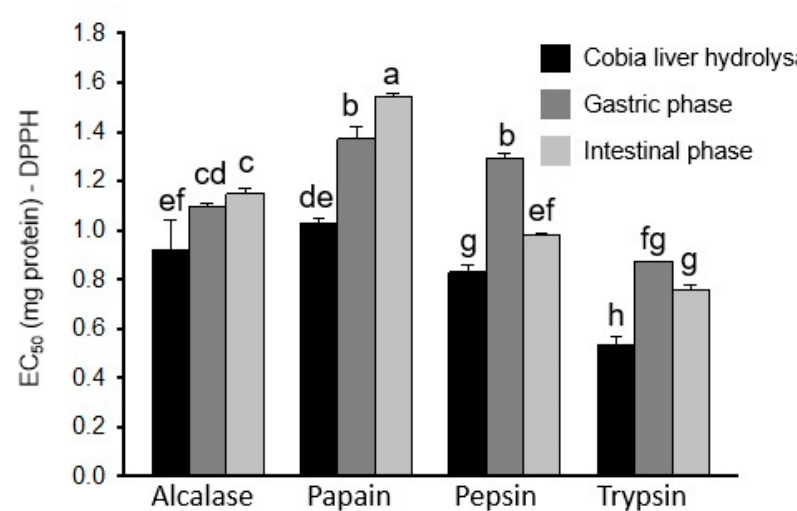
Figure 5. Effect of simulated gastro-intestinal digestion in vitro on EC 50 values (effective concentration scavenges 50% radical) for DPPH radical scavenging properties of cobia liver hydrolysates obtained from AE by alcalase, papain, pepsin, and trypsin treatment. Means with different superscript letters significantly differ ( p < 0.05).